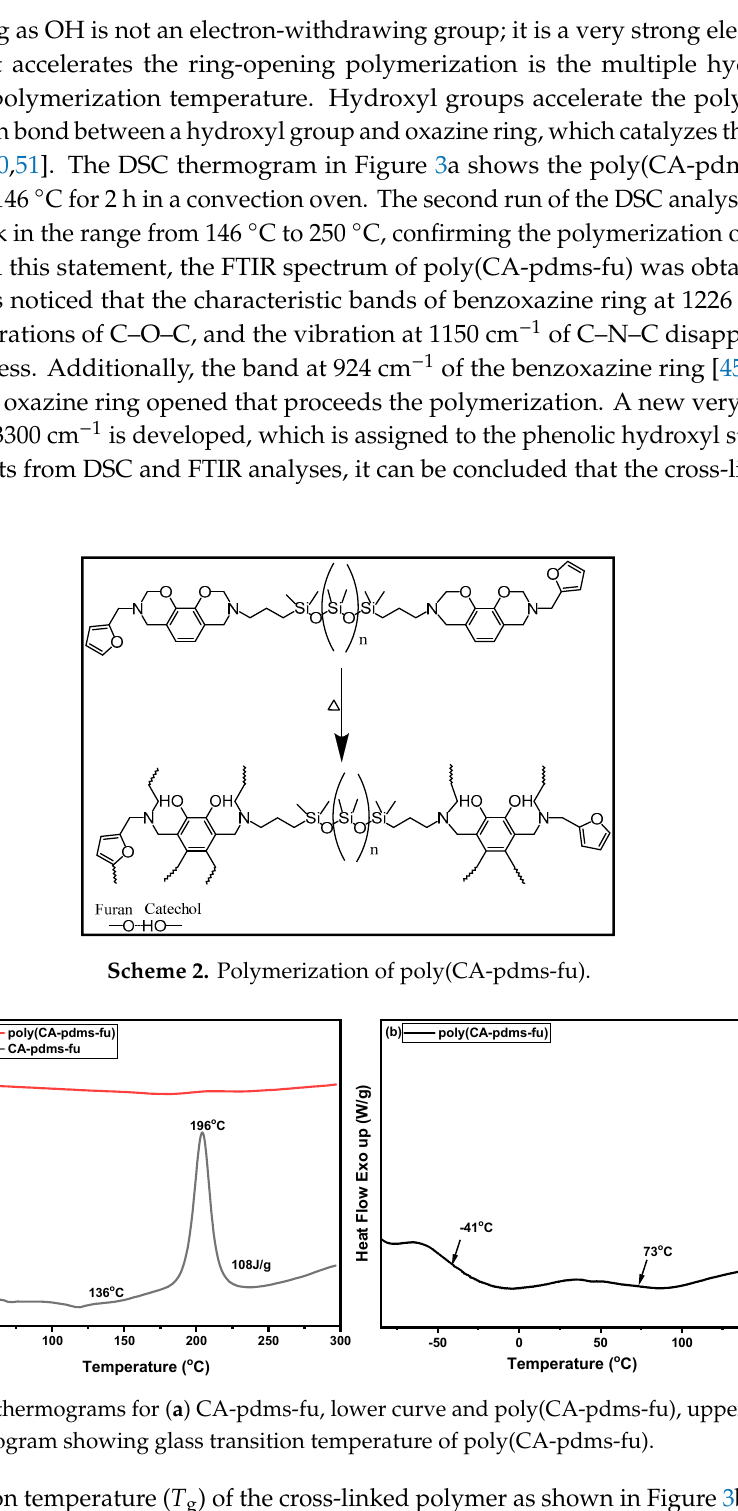
7 of 25 Figure 1. FTIR spectrum of CA-pdms-fu. The 1 H NMR spectra, shown in Figure 2, further confirmed the structure of CA-pdms-fu and its reactants. The resonance of Si–CH 3 protons appeared at 0.0–0.01 ppm. The resonances of Si–CH 2 – CH 2 , Si–CH 2 –CH 2 , and N–CH 2 protons appeared at 0.5, 1.5, and 2.7 ppm, respectively, while the protons of CH 2 of the furfurylamine appeared at 3.7 ppm. In our main-chain type benzoxazine, they appeared in the range 4.90–4.92 ppm for the O–CH 2 –N group and 3.91–3.99 ppm for the Ar–CH 2 –N group. Due to the possibility of different magnetic environments, multiple resonances for the CH 2 group are possible and a very detailed study is needed before we can assign each resonance. Nonetheless, they are in the general range of the characteristic resonances of the oxazine ring that are